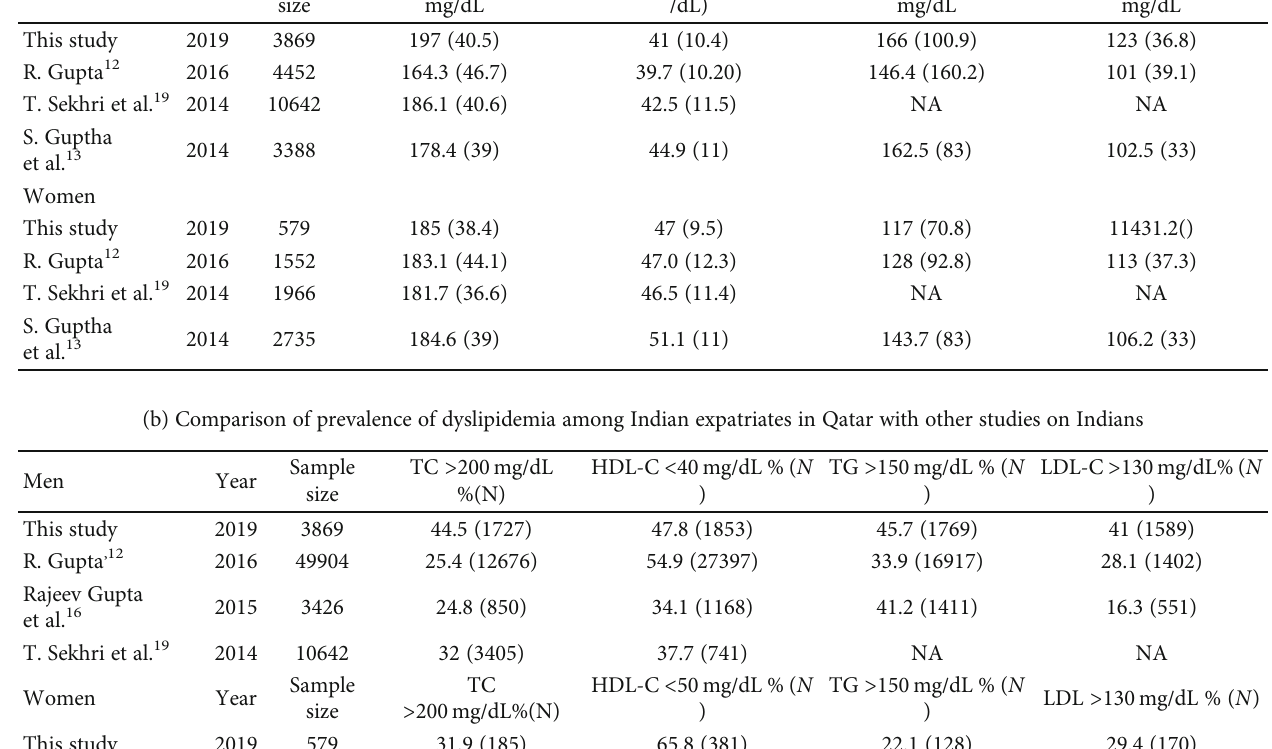
(a) Comparison of mean lipid levels of Indian expatriates in Qatar with other studies on Indians Men